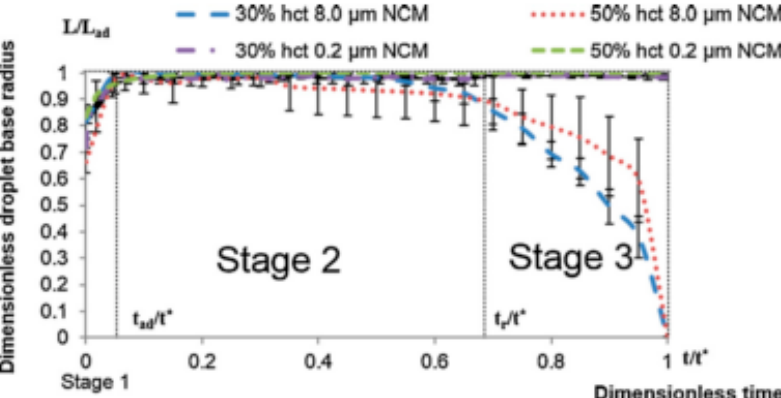
Figure 7. Dimensionless radius of the blood droplet base in the case of spreading over nitrocellulose membrane. In the case of 0.2 µm pores of nitrocellulose membrane only stage 1 and 2 are present [38].